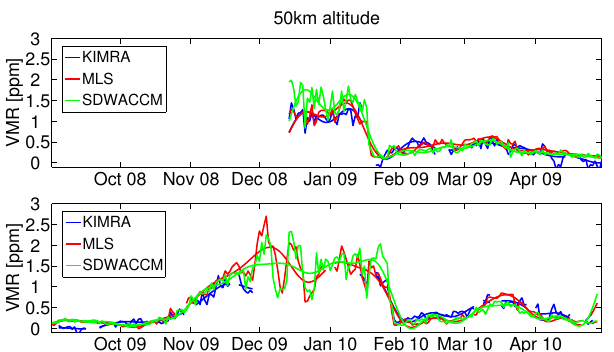
Fig. 3. Evolution of the CO vmr at 50km altitude, as measured by KIMRA and MLS and as simulated by SD-WACCM4 during the full KIMRA period. The smooth curves are the LF variations, obtained by eliminating all Fourier components with periods less than 20 days from the spectrum of the time series. See text for details.